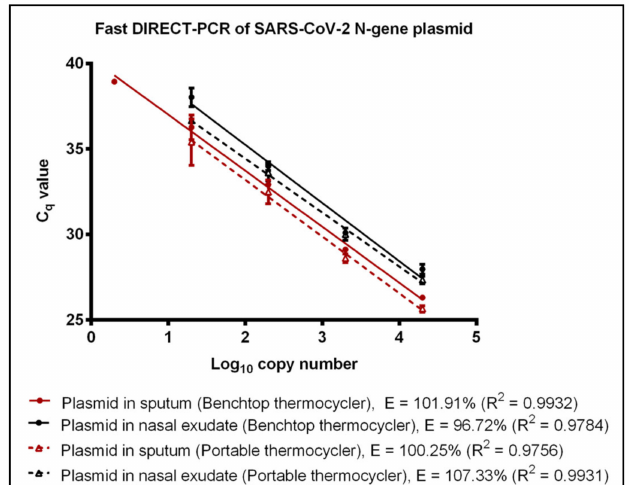
Figure 2. Fast DIRECT-PCR assay amplification e ffi ciency of SARS-CoV-2 N gene plasmid spiked in sputum (red line) and N gene plasmid spiked in nasal exudate (black line) using the benchtop thermocycler (solid line) and the portable thermocycler (dotted line). Templates were ten-fold diluted in 6 orders of magnitude. One microliter of template was used in 10 µ L of PCR